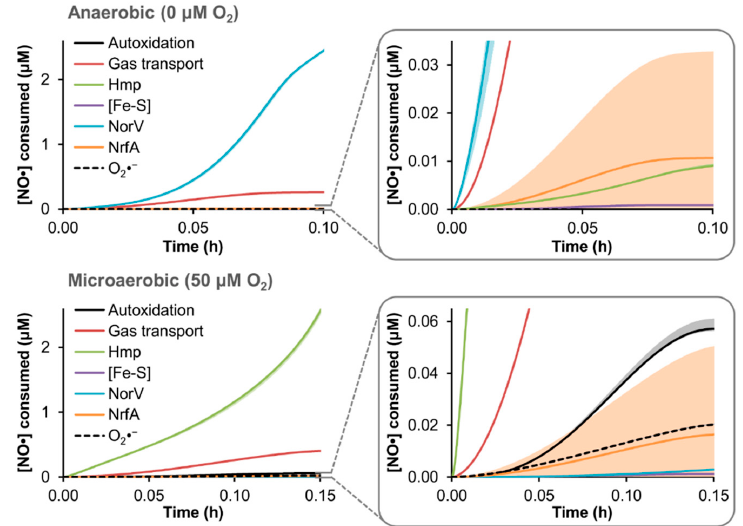
Figure 4. Simulated distribution of NO· consumption in an EHEC culture. The model was used to simulate treatment of a TUV hmp + / norV + culture at an OD 600 of 0.05 with 50 μ M DPTA NONOate under conditions of 0 or 50 μ M O 2 , and the resulting distribution of cumulative NO· consumption among the available pathways is shown, up to the approximate time when NO· was cleared (<0.1 μ M NO·) from the culture. Lines are predictions obtained using the best-fit parameter set, while lighter shading of a similar color represent prediction uncertainty (range of viable parameter sets with ER < 10). “Autoxidation” is NO· autoxidation, “Gas transport” is loss of NO· to the gas phase, “Hmp” is Hmp-mediated NO· detoxification, “[Fe-S]” is nitrosylation of iron-sulfur clusters, “NorV” is NorV-mediated NO· detoxification, “NrfA” is NrfA-mediated detoxification, and “O 2 · − ” is reaction of NO· with superoxide.